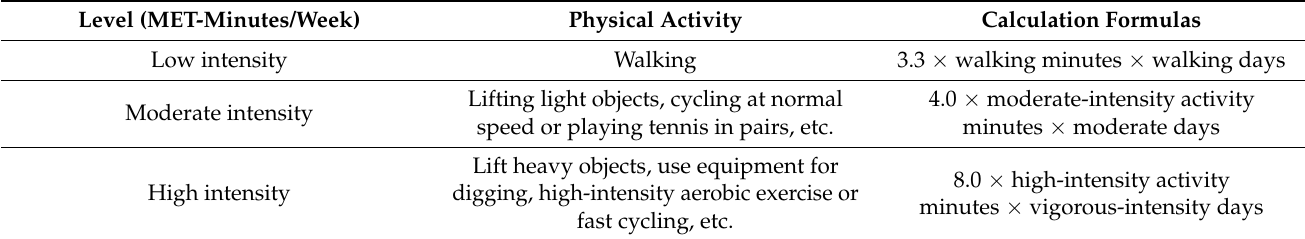
Table 2. Formula for calculating metabolic equivalents for computation of MET minutes.